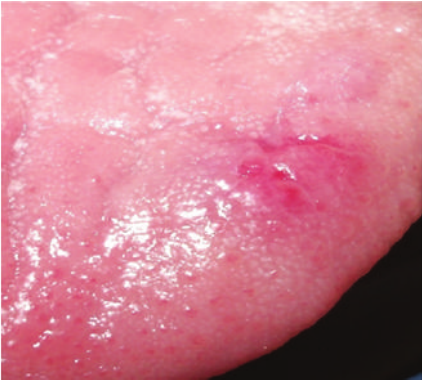
Figure 6: 1 week postoperative photograph.